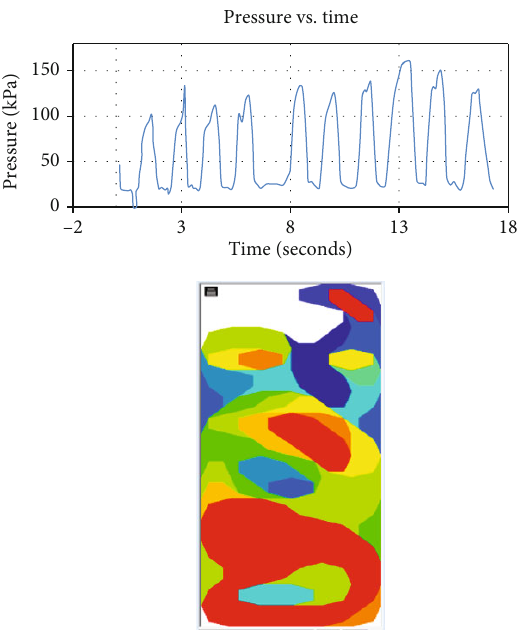
Figure 11: Pressure with time at the lateral